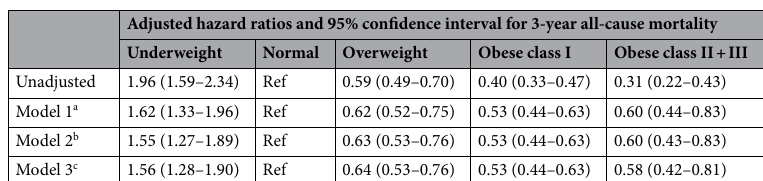
Table 3. Adjusted association between BMI categories and risk of all-cause mortality in patients with acute severe hypertension. The body-mass index was < 18.5 in underweight group, 18.5 to 22.9 in normal group, 23.0 to 24.9 in overweight subjects, 25.0 to 29.9 in obese class I group, and ≥ 30.0 in obese class II + III group. BMI, body mass index. Values are presented as the hazard ratio (95% confidence interval). a Adjusted for age and sex. b Adjusted for age, sex, hypertension, diabetes mellitus, dyslipidemia, ischemic stroke, hemorrhagic stroke, chronic kidney disease, end-stage renal disease, smoking, and alcohol. c Adjusted for age, sex, hypertension, diabetes mellitus, dyslipidemia, ischemic stroke, hemorrhagic stroke, coronary artery disease, heart failure, chronic kidney disease, end-stage renal disease, smoking, and alcohol, which were variables with p value < 0.2 in the univariate analysis.